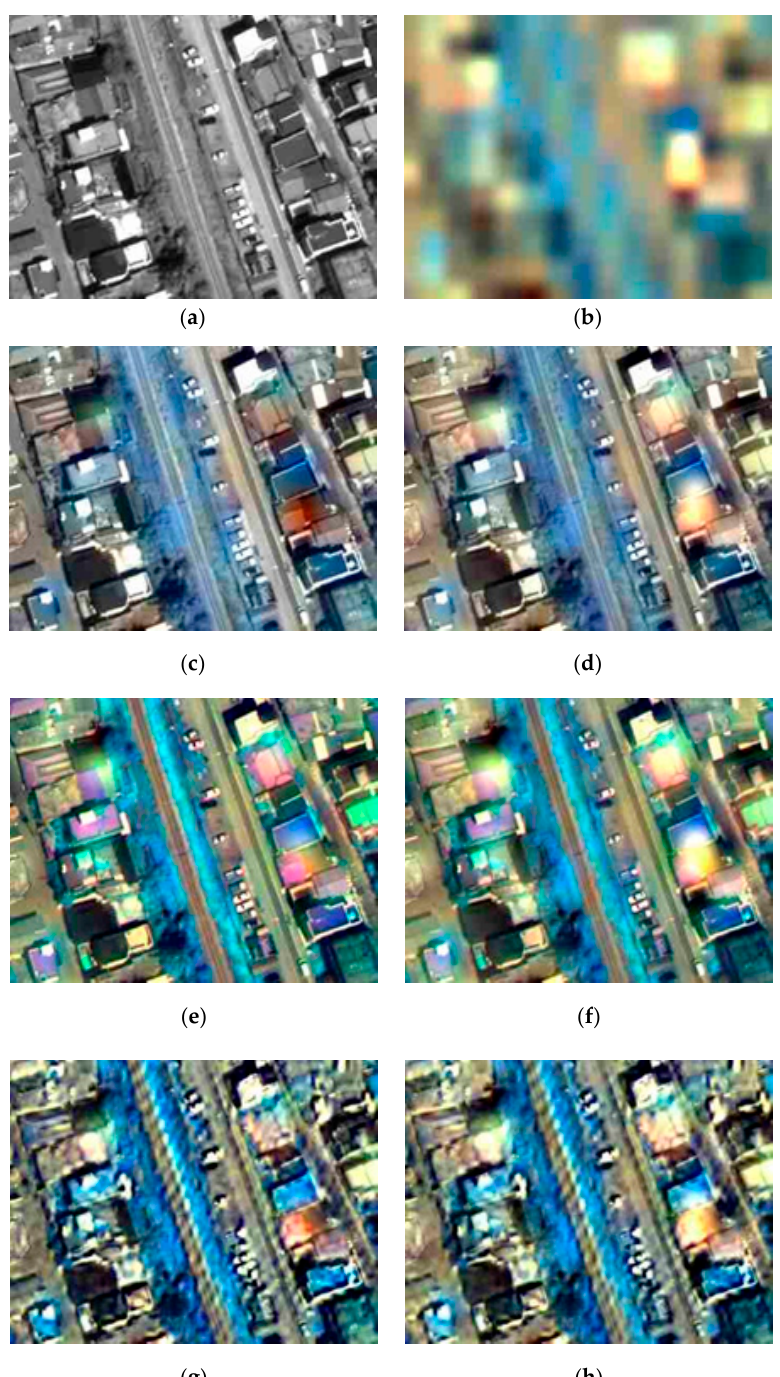
Figure 4. Pansharpening results of SWIR bands for site 1 (SWIR bands 8, 4, and 1 are shown as RGB):